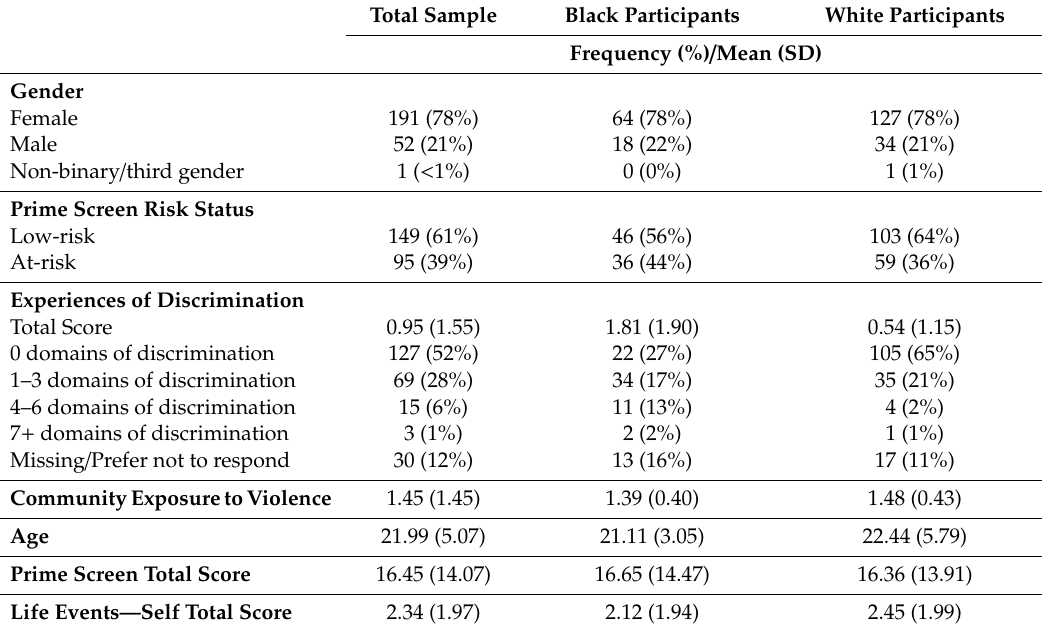
Table 1. Descriptive Statistics and Frequencies for Study